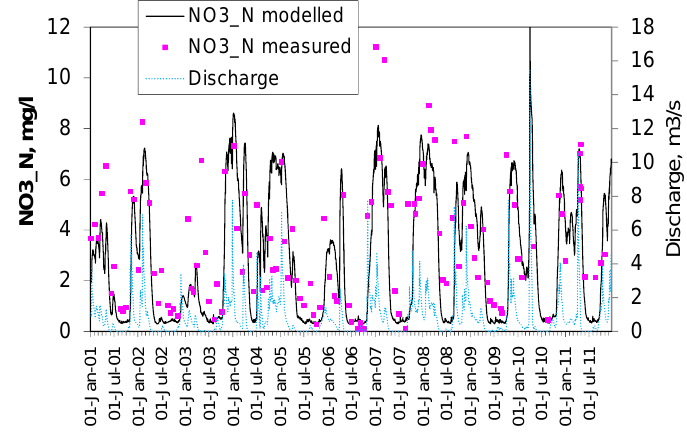
Figure 2. Measured and modelled nitrate nitrogen and water discharge.